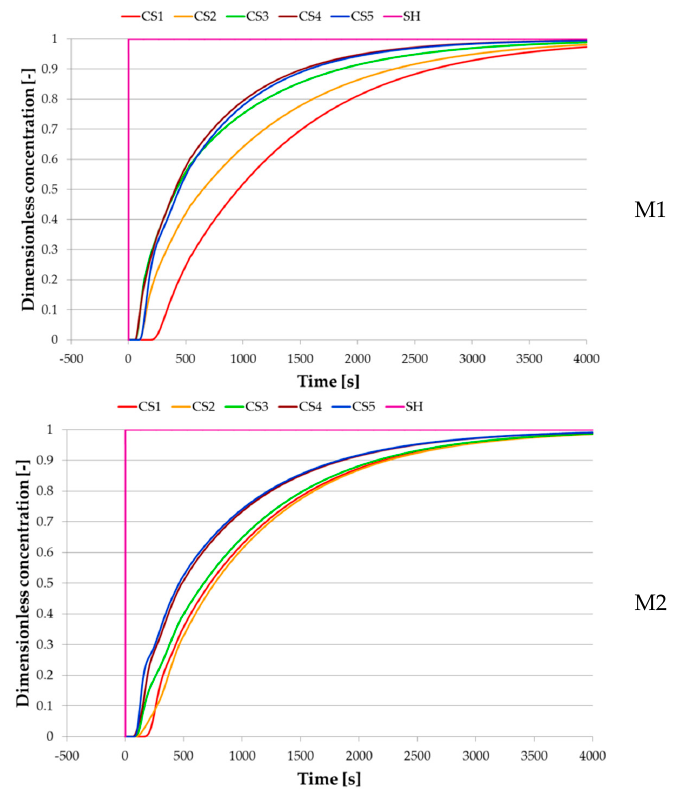
Figure 8. Comparison of F curves in monitoring change in tracer concentration during the passage through a tundish during the steady steel flow.